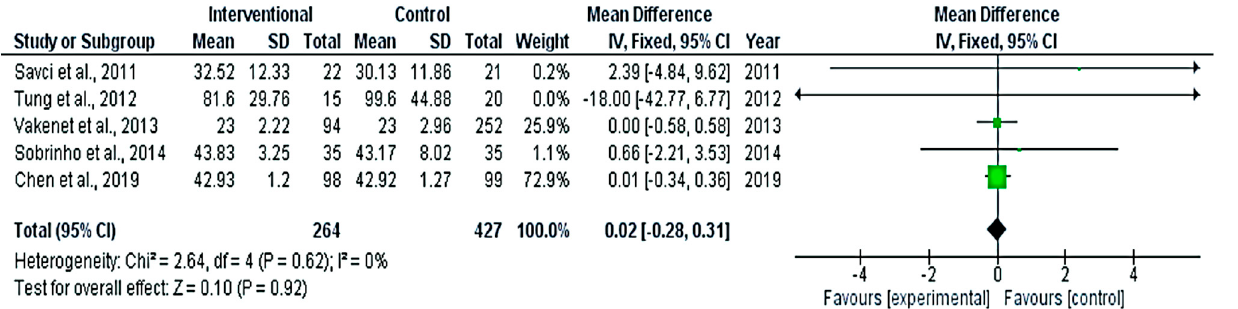
Figure 4. Forest plot evaluating mechanical ventilation duration in the included studies.